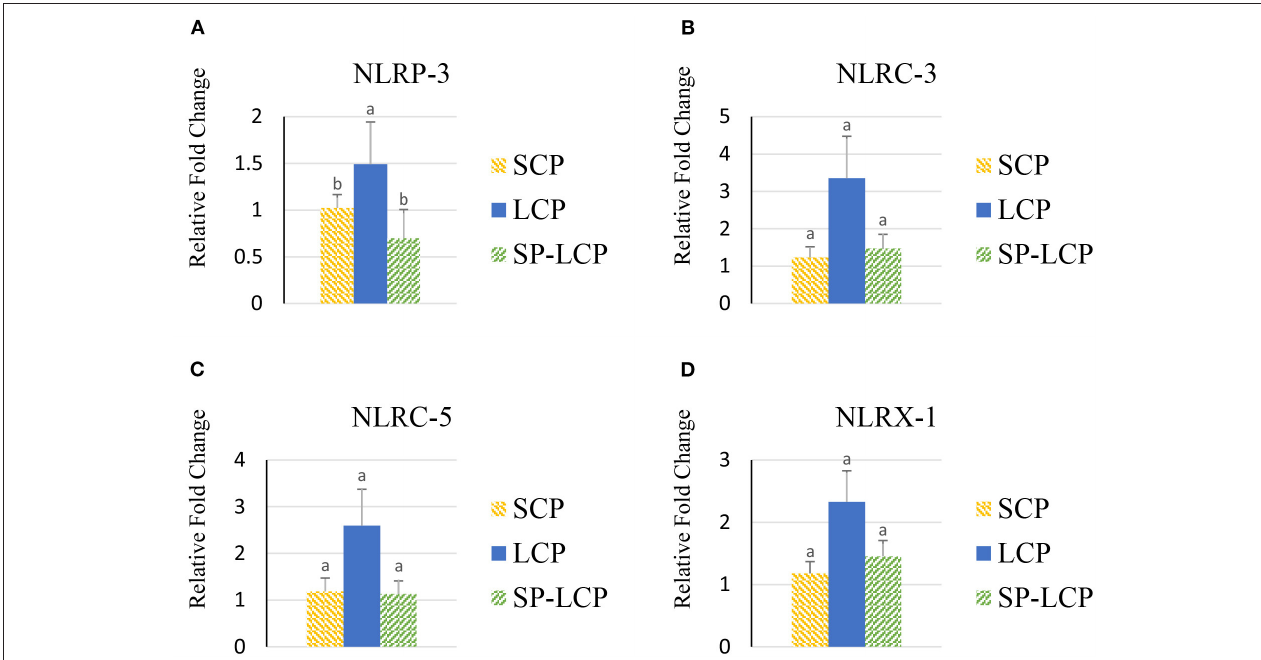
FIGURE 4 | Effects of Spirulina on circulating inflammasome expression. Relative mRNA abundance of NOD-like receptor family pyrin domain-containing 3 (NLRP-3) (A) , NOD-like receptor family CARD domain-containing 3 (NLRC-3) (B) , NOD-like receptor family CARD domain-containing 5 (NLRC-5) (C) , and nucleotide-binding oligomerization domain, leucine-rich repeat-containing X1 (NLRX-1) (D) in broilers on day (d) 37 were determined by real-time qPCR. Treatments include standard corn/soy (SCP) diet as control and low crude protein without (LCP) or with Spirulina (SP-LCP). Data are presented as mean ± SEM ( n = 8/group). Means with different letters are significantly different ( P <